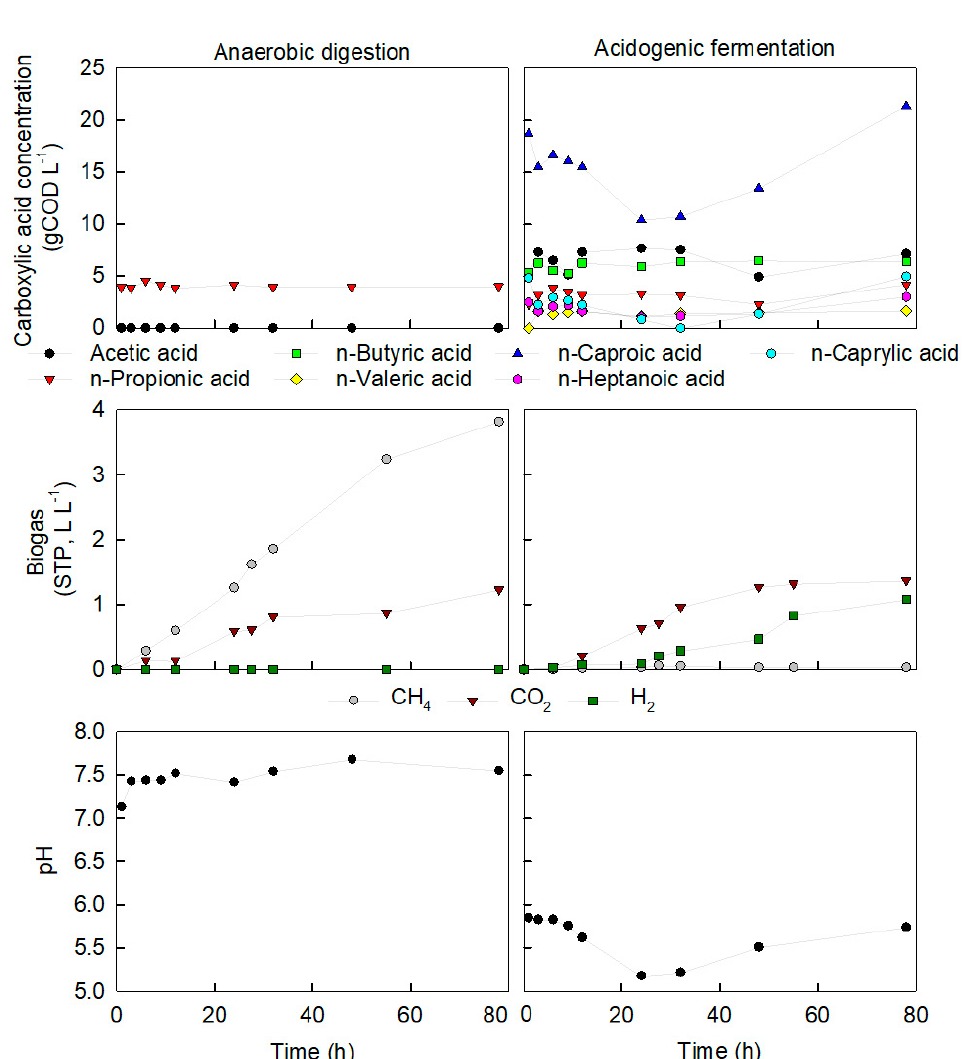
Figure 3. Concentration of carboxylic acids ( top ), biogas production ( middle ) and pH profile ( bottom ) in between two feeding events (Day 21 and 24 of Phase 2) for AD ( left ) and AF ( right ). Time 0 corresponds to a sample taken straight after feed addition. Table 3. Alpha-diversity indices for the microbial community in the AD and AF reactors. Averaged over duplicate samples and calculated based on 20,314 reads per sample.